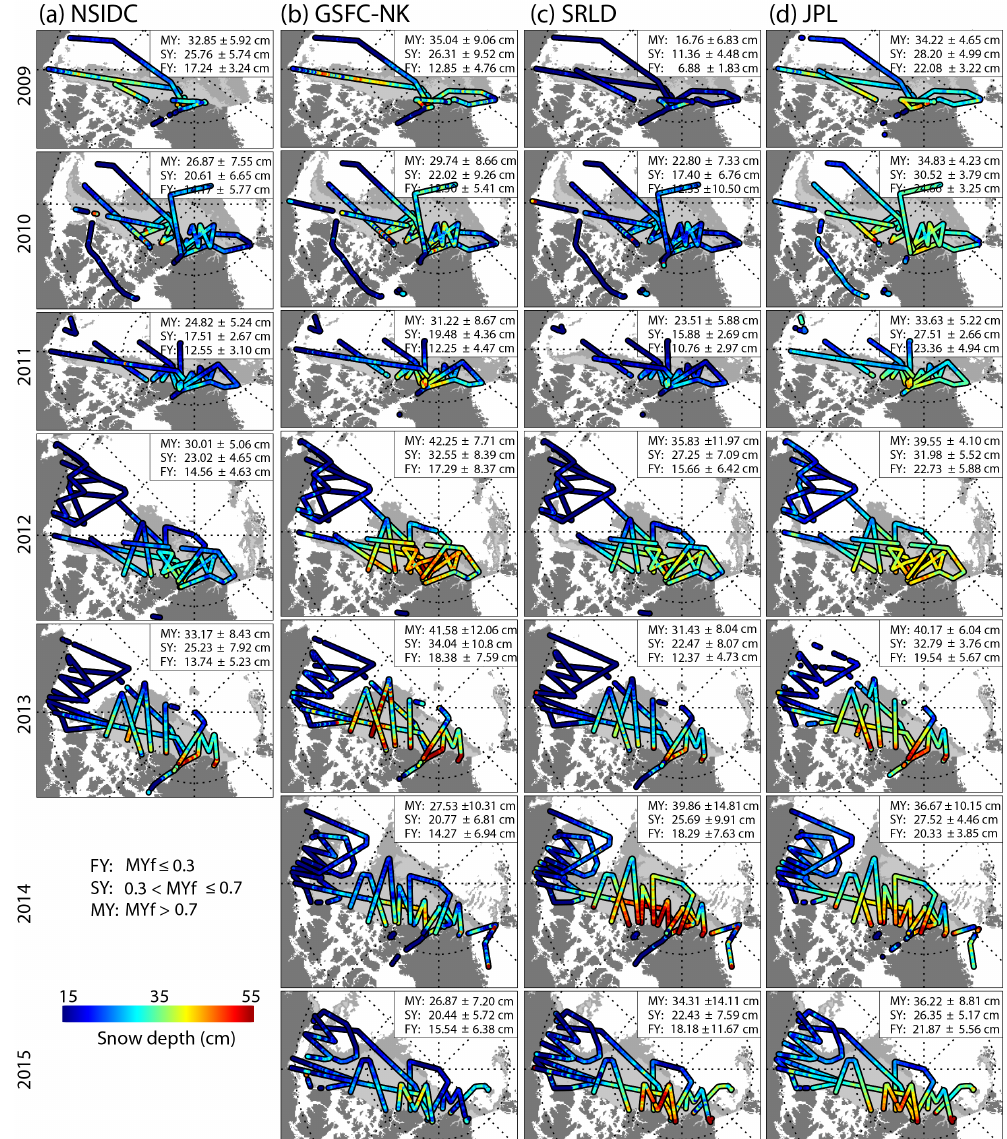
Figure 7. Seven years (2009–2015) of retrieved snow depths from four algorithms: (a) NSIDC, (b) GSFC-NK, (c) SRLD, and (d) JPL. Snow depths (top-left corner) are averages based on three categories of multiyear ice fractions (MYf) shown in legend. Background shows multiyear sea ice fraction (dark gray: MYf ≥ 0.7; light gray: 0.3 < MYf < 0.7; white: MYf ≤ 0.3). Corresponding snow depth distributions are shown in Fig. 8. The gray shadings represent regions with > 0.7 (darker) and > 0.9 (lighter) MYf. Repeat tracks are not shown